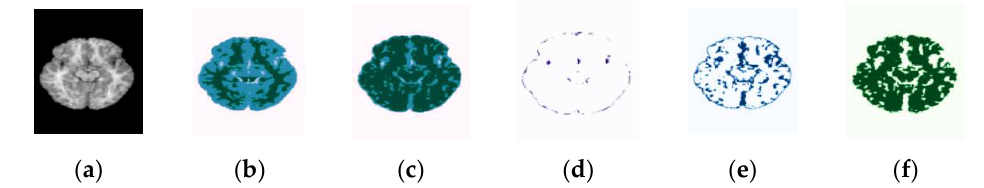
Figure 11. Segmentation results of the proposed method trained for the OASIS dataset and tested on IBSR data: ( a ) original input images, ( b ) ground-truth segmentation maps, ( c ) predicted segmentation maps obtained under the proposed method, ( d ) predicted binary maps of CSF, ( e ) predicted binary maps of GM, and ( f ) predicted binary maps of WM.